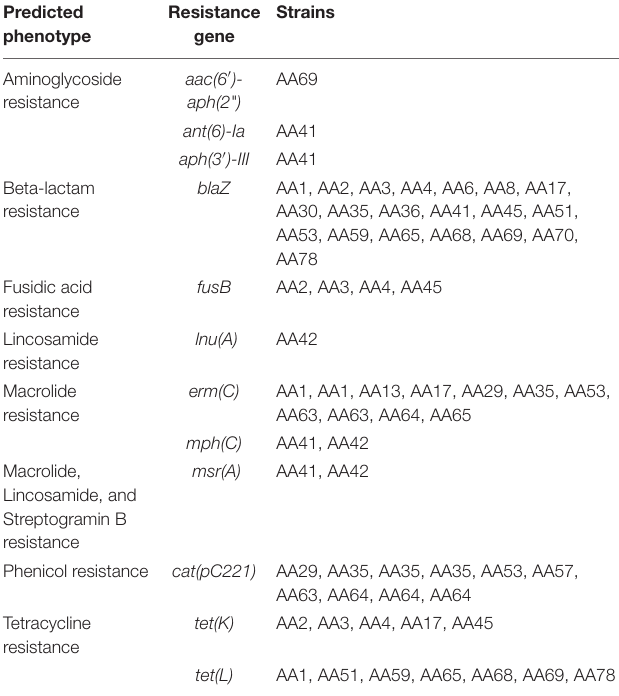
TABLE 4 | Resistance genes carried on Egyptian S. aureus and S. haemolyticus